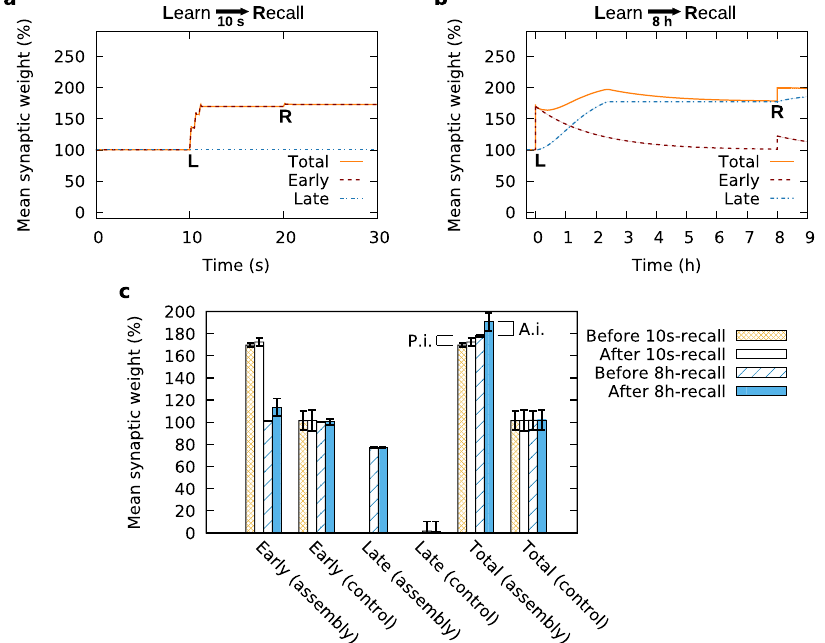
Fig. 6 Synaptic dynamics related to memory formation, consolidation and improvement. a During the fi rst seconds after the learning stimulus ( “ L ” ), the average early-phase weight (red) of the synapses connecting the stimulated neurons increases, while the average late-phase weight remains constant (blue). A recall stimulus ( “ R ” ), provided 10 s after the learning stimulus, does not exert a substantial effect on the synaptic weights. b Several hours after learning, the average early-phase weight decays, while the late-phase increases such that the average total synaptic weight remains on a high level. Providing a recall stimulus 8 h after learning triggers an increase of the average early-phase weight and, thus, of the total synaptic weight. a , b Averaged over ten trials; the error bands (representing the standard deviation) are too small to be visible. c Mean early- and late-phase weights within the assembly and within the non-assembly (control) population immediately before and immediately after the 10s and 8h-recall. A.i. active improvement component (difference between solid blue and blue hatches); P.i. passive improvement component (difference between orange grating and blue hatches). Data from one sample network. Error bars show the standard deviation across the subpopulation. See Supplementary Figs. S4 and S5 for detailed distributions of the underlying data. Parameter setting: w ie / h 0 = 4, w ii / h 0 = 4, n CA =